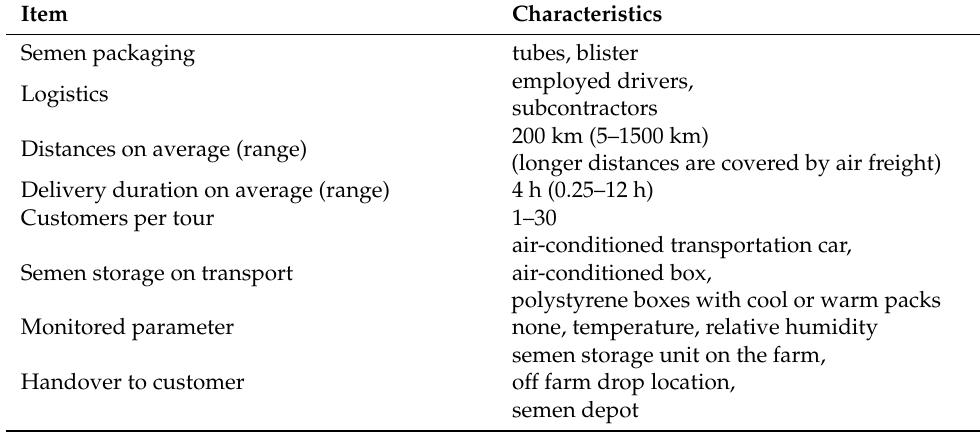
Table 1. Summary of data concerning boar semen shipping in Brazil, Germany, and